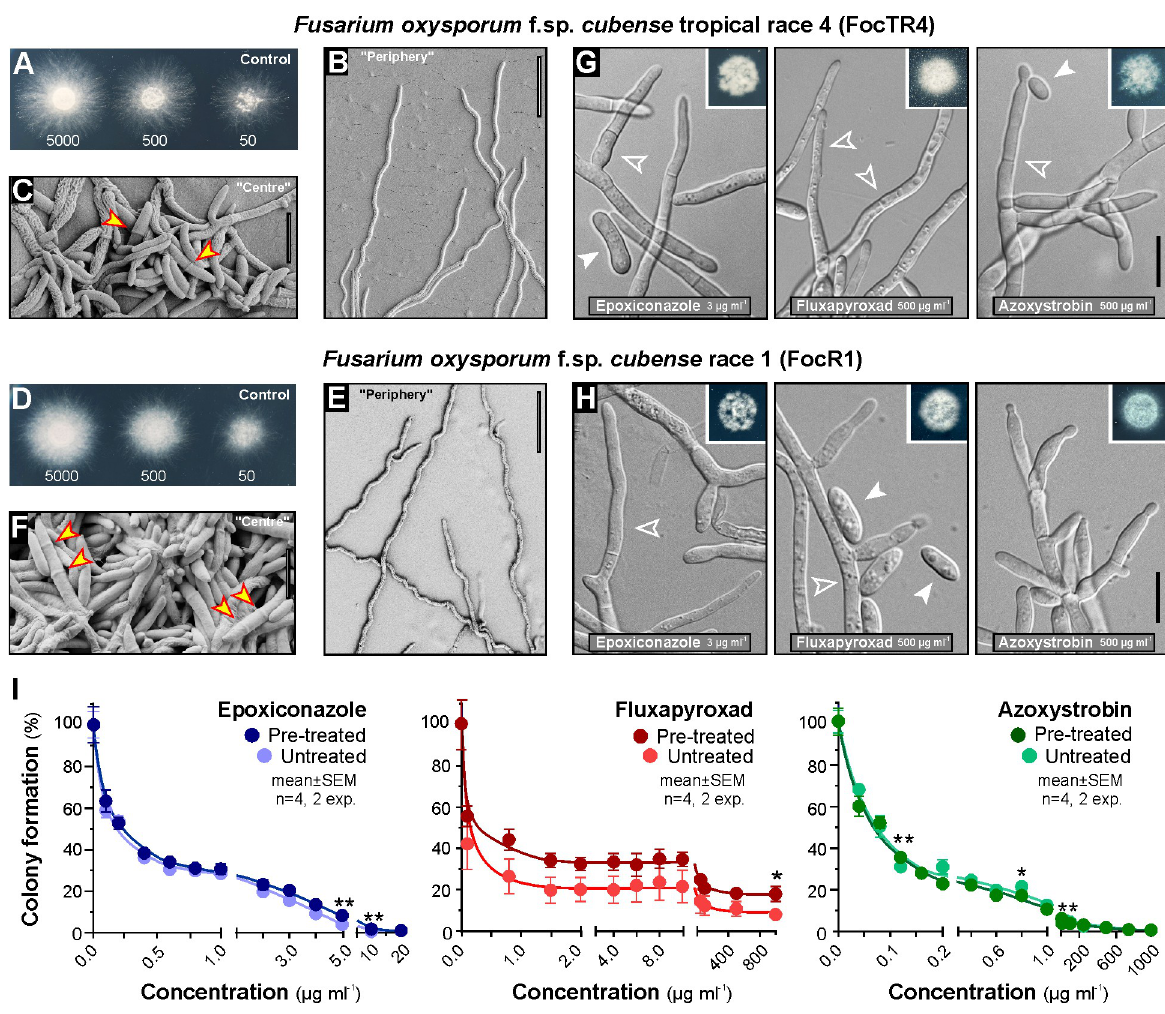
Fig 2. The effect of various fungicides on growth of FocTR4 and FocR1 on agar. A FocTR4 colonies on PDA plates after 2 days growth at 25˚C. Note that colonies contain of central region of densely grown cells and a "corona" of more diffuse spreading hyphae. Numbers of inoculated microconidia per colony are indicated. B , C Scanning electron micrographs of cells at the edge ( B ) and the centre ( C ) of a colony of FocTR4, grown on PDA agar plates. The central region shows yeast-like cells, which are occasionally multi-cellular (septa indicated by arrowheads), thus may resemble micro- or macroconidia; the peripheral region consists of hyphae. Scale bars = 10 μ m ( C ) and 50 μ m ( B ). D FocR1 colonies on PDA plates after 2 days growth at 25˚C. Numbers of inoculated microconidia per colony are indicated. E , F Scanning electron micrographs of cells at the edge ( E ) and the centre ( F ) of a colony of FocR1, grown on PD agar plates. The central region shows yeast-like cells, which are occasionally multi- cellular (septa indicated by arrowheads), thus may resemble micro- or macroconidia; the peripheral region consists of hyphae. Scale bars = 10 μ m ( F ) and 50 μ m ( E ). G , H Morphology of FocTR4 ( G ) and FocR1 ( H ) persister cells, harvested from PDA plates after 2 days grown in the presence of 3 μ g ml -1 epoxiconazole, 500 μ g ml -1 fluxapyroxad or 500 μ g ml -1 azoxystrobin. Colonies from where cells were taken are shown in the upper right. Scale bars = 10 μ m. I Colony growth of FocTR4 persisters on fungicide-supplemented agar plates. Pre-treated: Cells were pre-grown for 2d in liquid cultures, supplemented with 3 μ g ml -1 epoxiconazole, 500 μ g ml -1 fluxapyroxad or 500 μ g ml -1 azoxystrobin, harvested and plated on fungicide-containing agar plates; Untreated: Cells were pre-grown for 2d in liquid cultures, supplemented with 0.06–2.5% (v v -1 ) of the solvent methanol, harvested and plated on fungicide-containing agar plates. Note that colony formation on fungicide-supplemented agar plates by liquid- grown persister cells is almost identical to that of control cells. Non-linear regressions in was done using GraphPad Prism 6 (equation "[Inhibitor] vs. response—variable slope (four parameters)"). All data points are given as mean ± SEM, sample size is 4 colonies from 2 experiments; statistical testing used Student’s t-test, only significant differences are indicated ( � represents two-tailed P-value < 0.05; �� represents two-tailed P-value < 0.01).